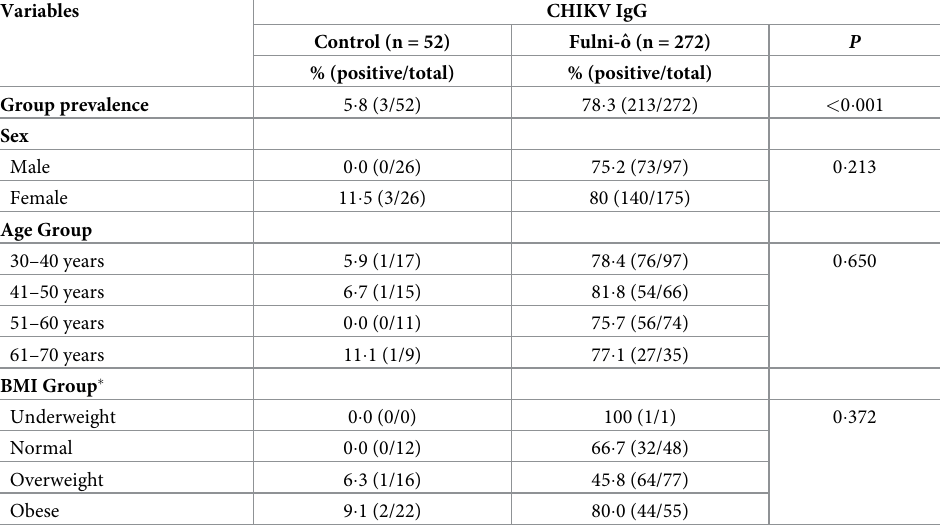
Table 2. Prevalence of CHIKV IgG antibodies in population groups (control, Fulni-oˆ, and Truka´) and association with age, sex, and anthropometric data.